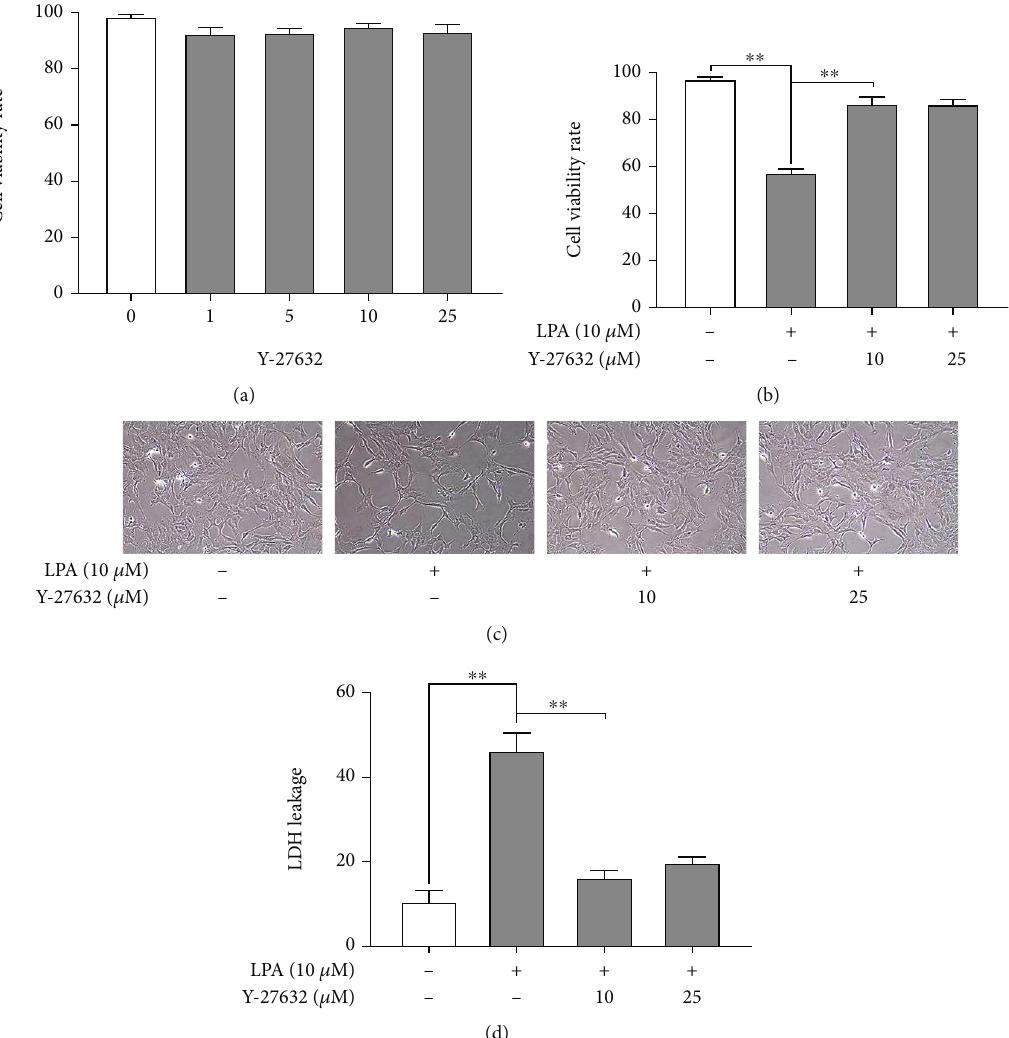
Figure 3: Rho kinase inhibitor alleviated cytotoxicity in the LPA-induced spinal cord neurons. (a, b) The cell viability was measured by MTT assay. (c) Cell viability was observed by microscope (100x). (d) The LDH release was measured by LDH assay kit. Asterisks indicate statistical signi fi cance ( ∗ p < 0 : 05 , ∗∗ p < 0 : 01